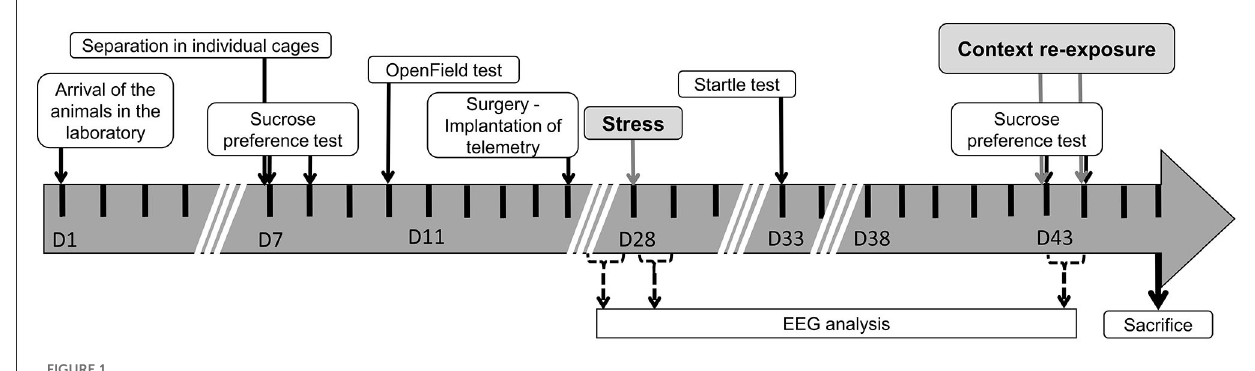
FIGURE1 Experimental time course.